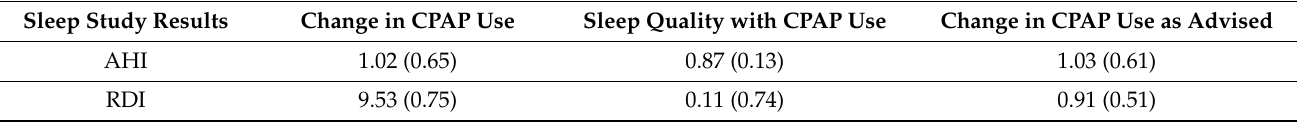
Table 3. Point-estimate of sleep study results and CPAP use during the COVID-19 pandemic.